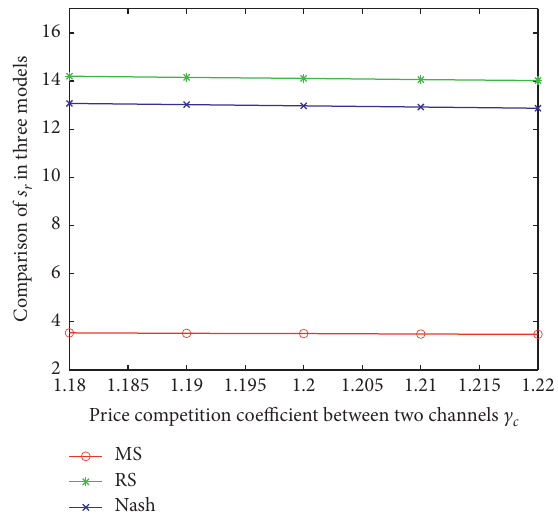
Figure 9: The comparison of the optimal service level of standard products in the retail channel s r in the three